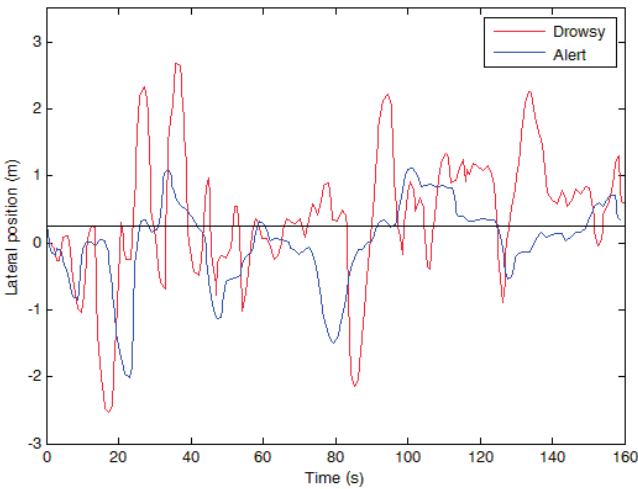
Figure 5. Vehicle lateral position within nine